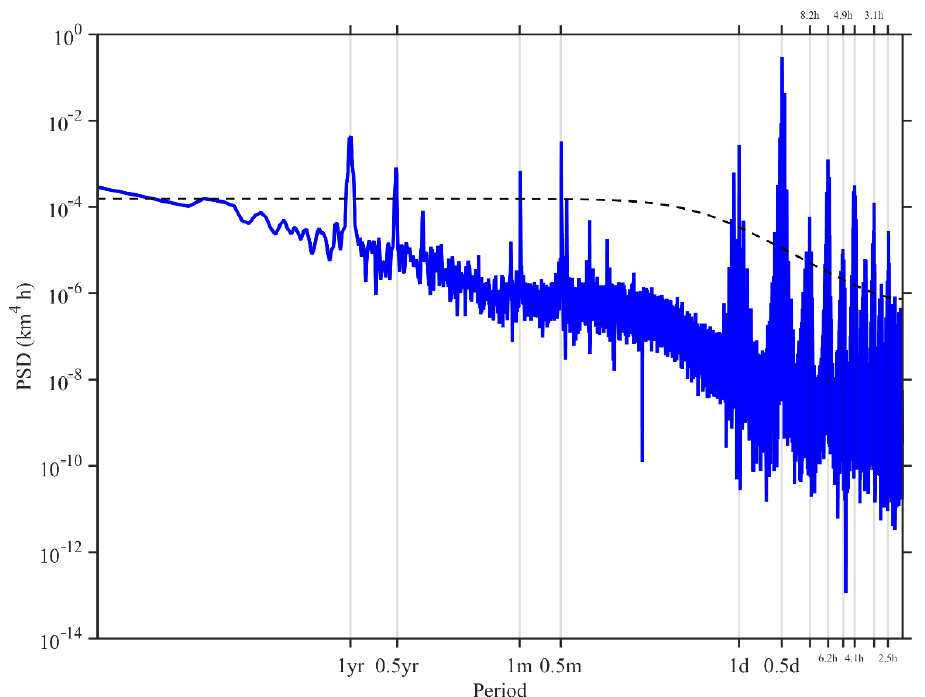
Figure 6. Power spectrum (km 4 h) of the wetland area. The dashed black line denotes the 95% con- fidence